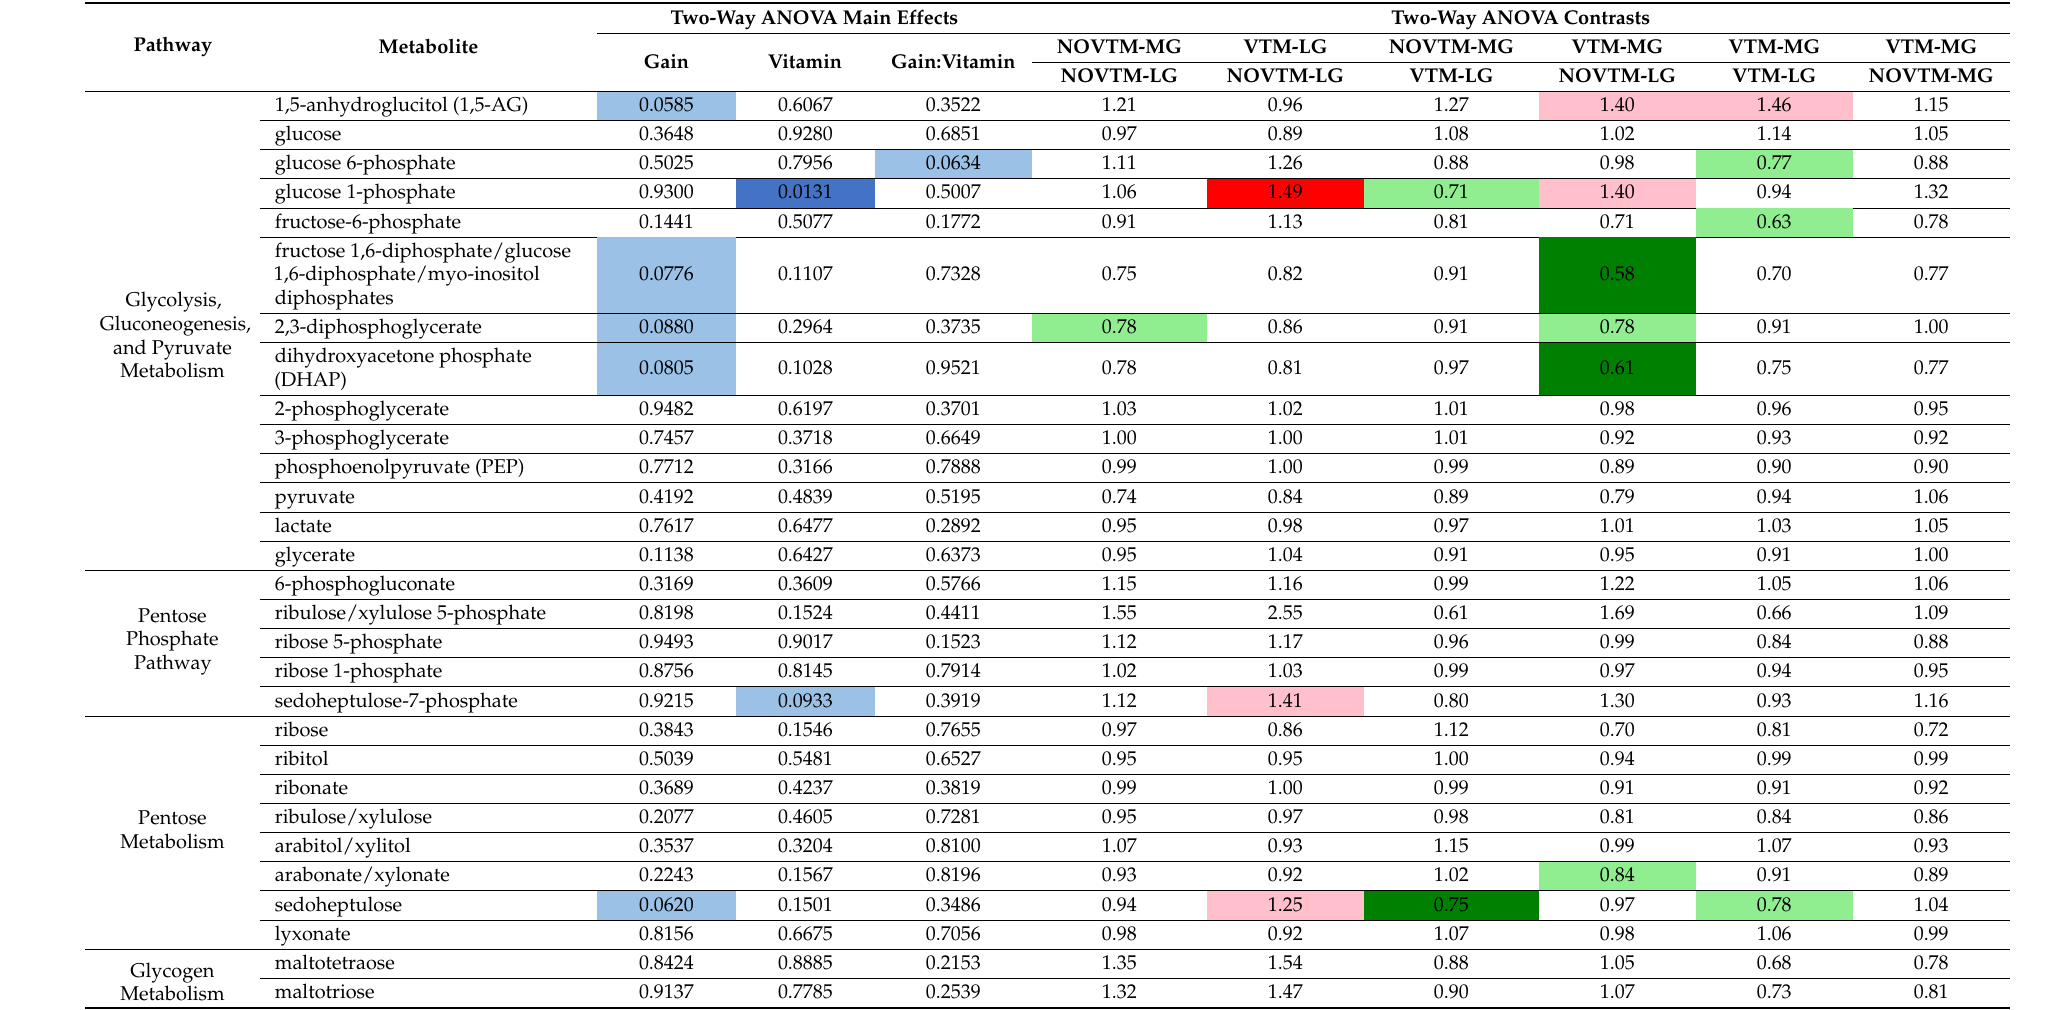
Table 5. Metabolites involved in carbohydrate metabolism pathways including: (1) Glycolysis, Gluconeogenesis, and Pyruvate, (2) Pentose Phosphate Pathway, (3) Pentose, (4) Glycogen, (5) Fructose, Mannose, and Galactose, (6) Nucleotide Sugar, (7) Aminosugar, (8) Advanced Glycation End-Product